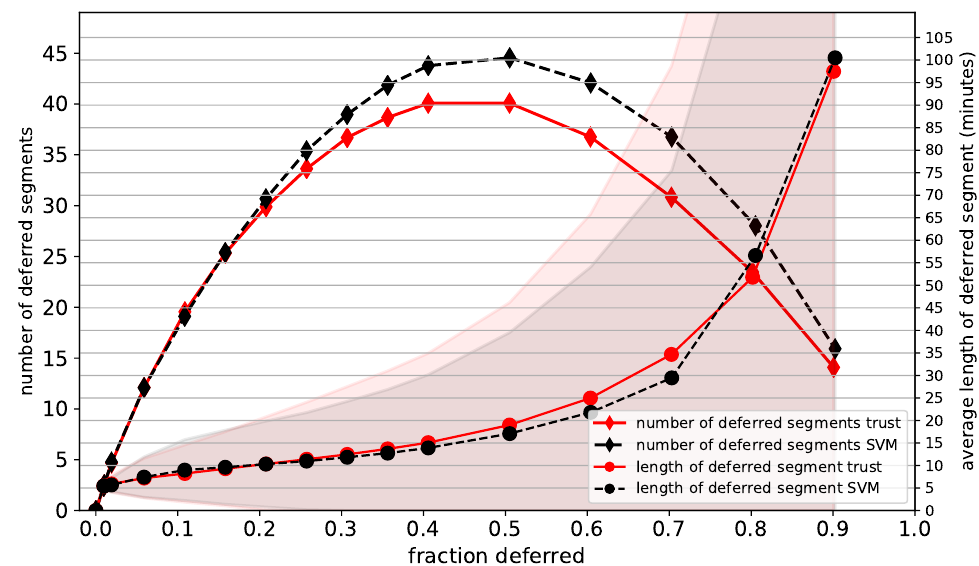
Figure 9. Average number and average length (minutes) of the deferred segments, as functions of the fraction of the data that is deferred to a human annotator, for the CI SVM ( p low = 5). The standard deviation of the length is shown as a shaded area, with the lower values being capped at zero. Segments were deferred using the SVM confidences (SVM) and trust scores (trust) from a trust model trained on the FS labels.